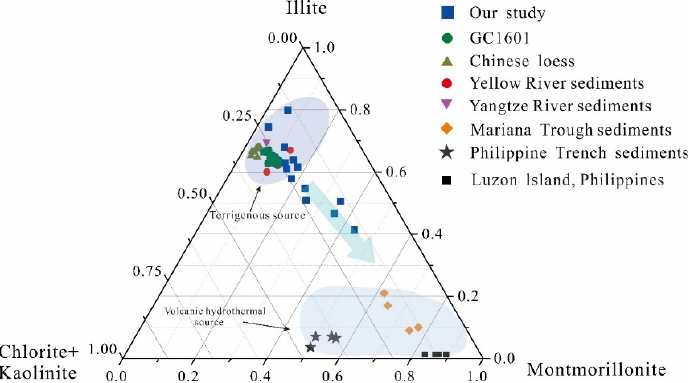
Figure 8. Ternary diagram showing variation in clay mineral compositions of sediments from our study and other geological regions. CG1601 sediment data are from [37], Chinese loess data are from [46], Yellow River sediments data are from [39–41], Yangtze River sediments data are from [47], Mariana Trough sediments data are from [48], Philippine Trench sediments data are from [49,50], Luzon Island sediments data are from [51].